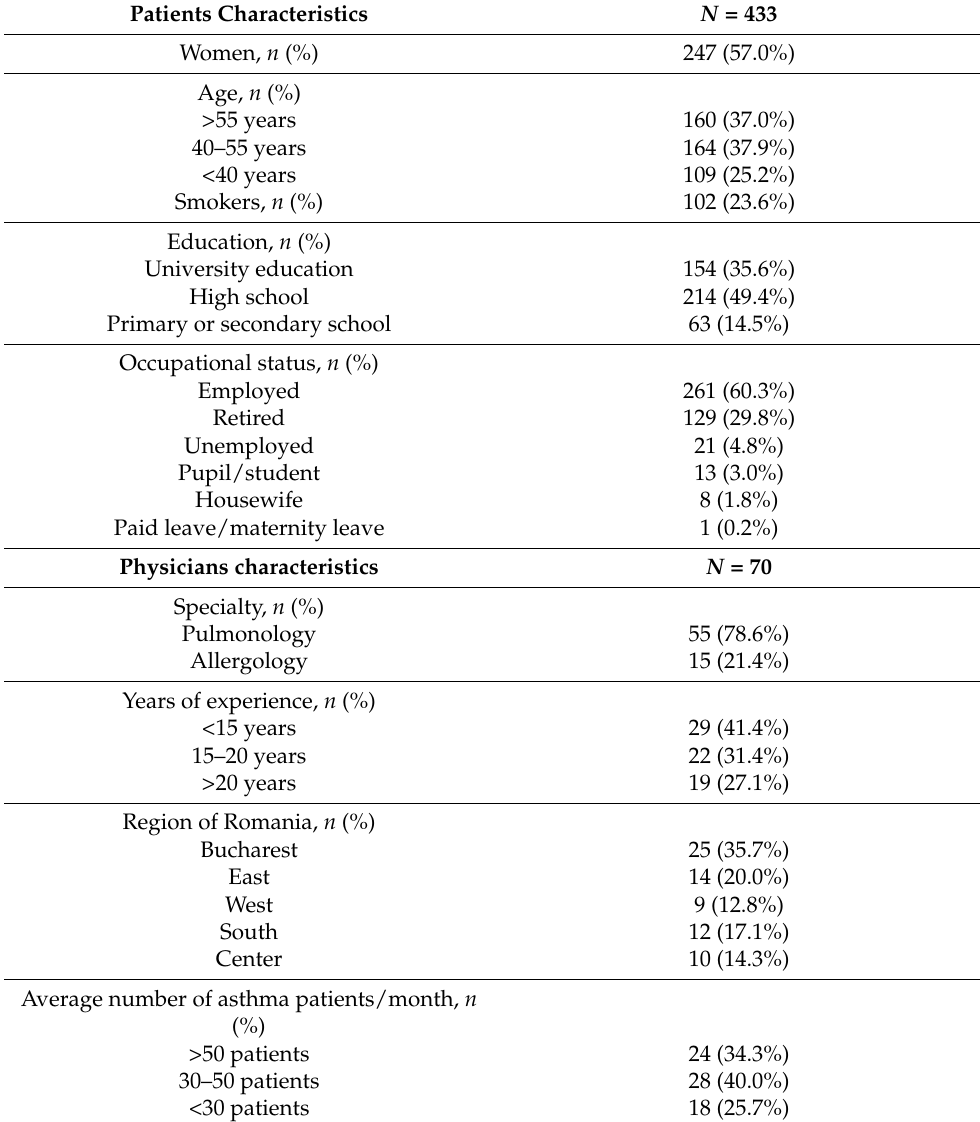
Table 1. Respondents’ demographic and clinical